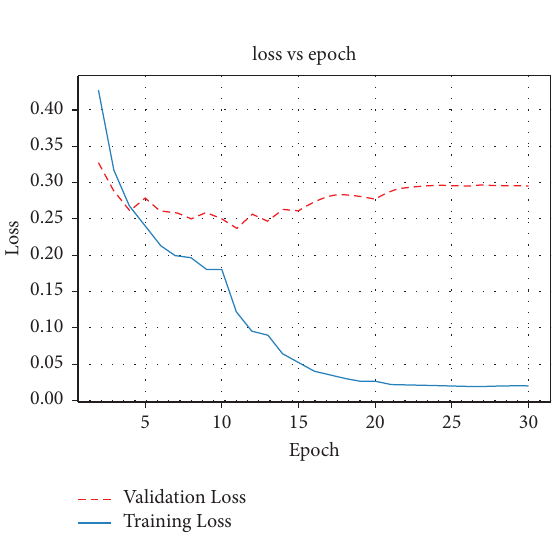
Figure 14: Observed loss for case 3.